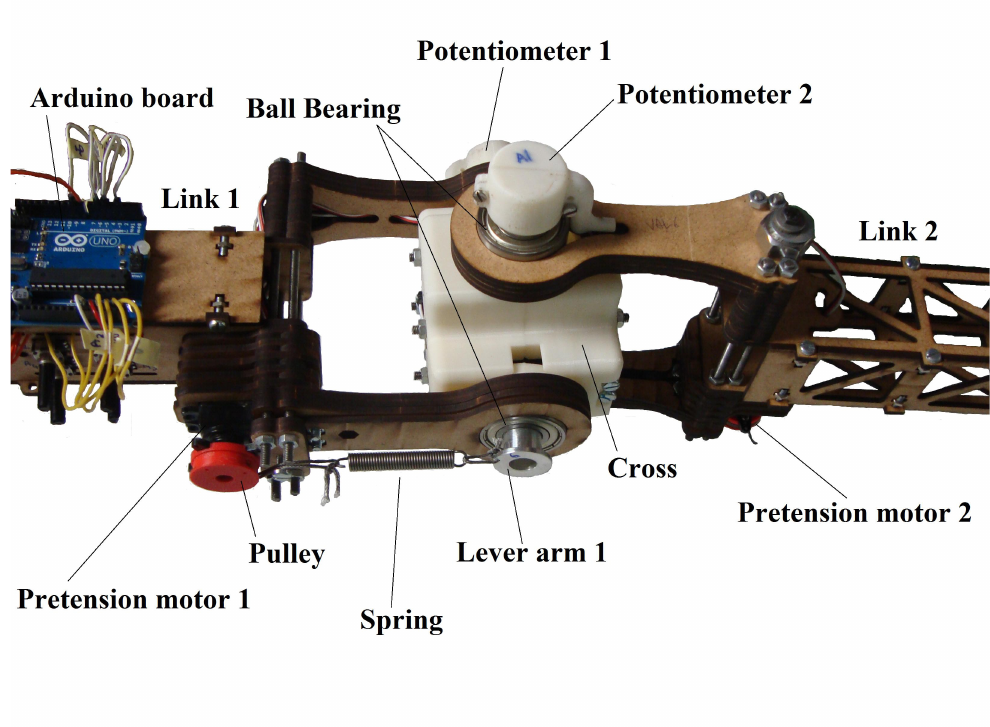
Figure 7. The two-degree of freedom